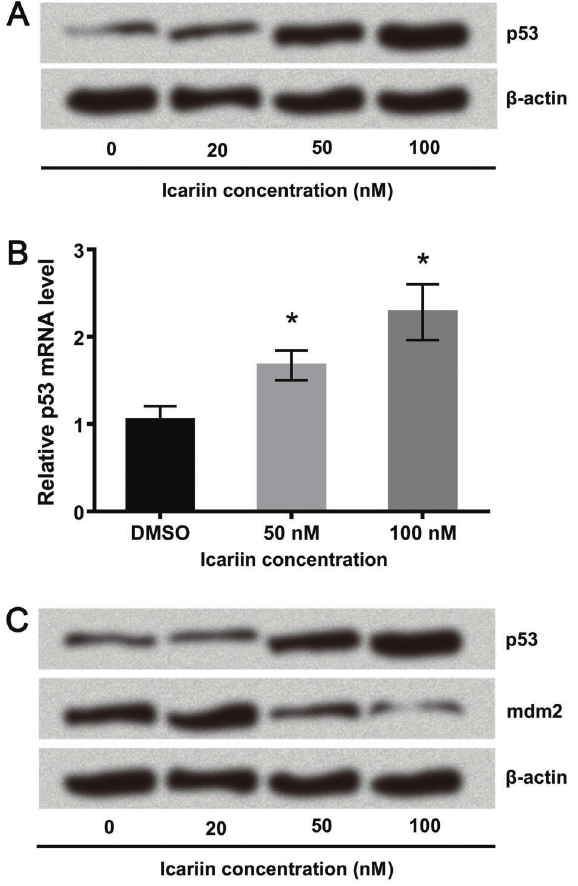
Figure 4. Expression of p53 was enhanced by icariin. A , The mRNA level of p53 was analyzed by real-time PCR. B and C , Protein levels of p53, p-p53, and mdm2 were detected by western blot analysis. b -actin was used as internal control. Assays were performed in triplicate. Data are reported as means ± SD. *P o 0.05 (ANOVA).